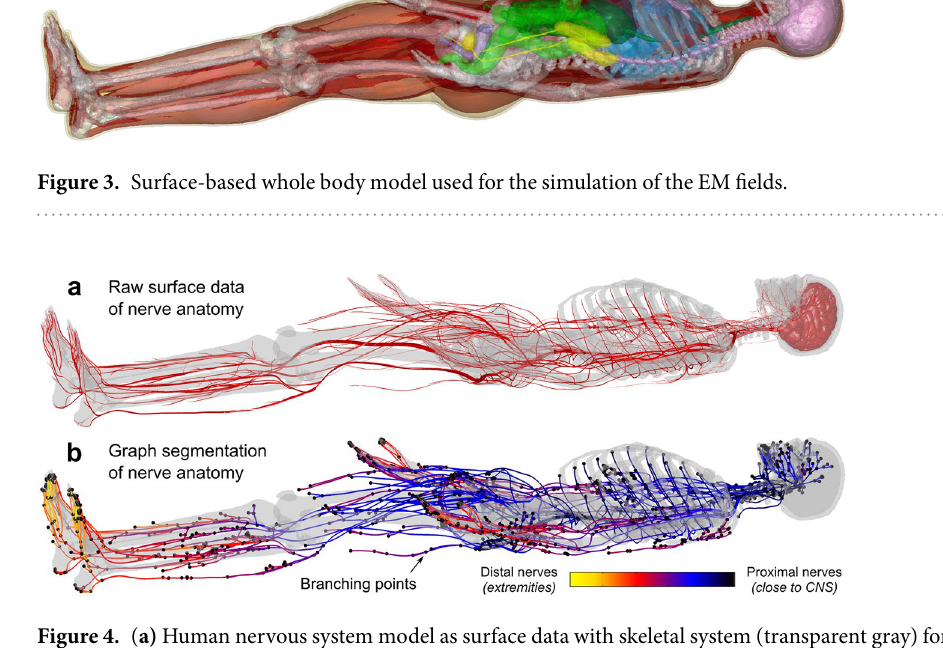
Figure 4. ( a) Human nervous system model as surface data with skeletal system (transparent gray) for reference. ( b) Extracted nerve centerlines color coded by distance from the